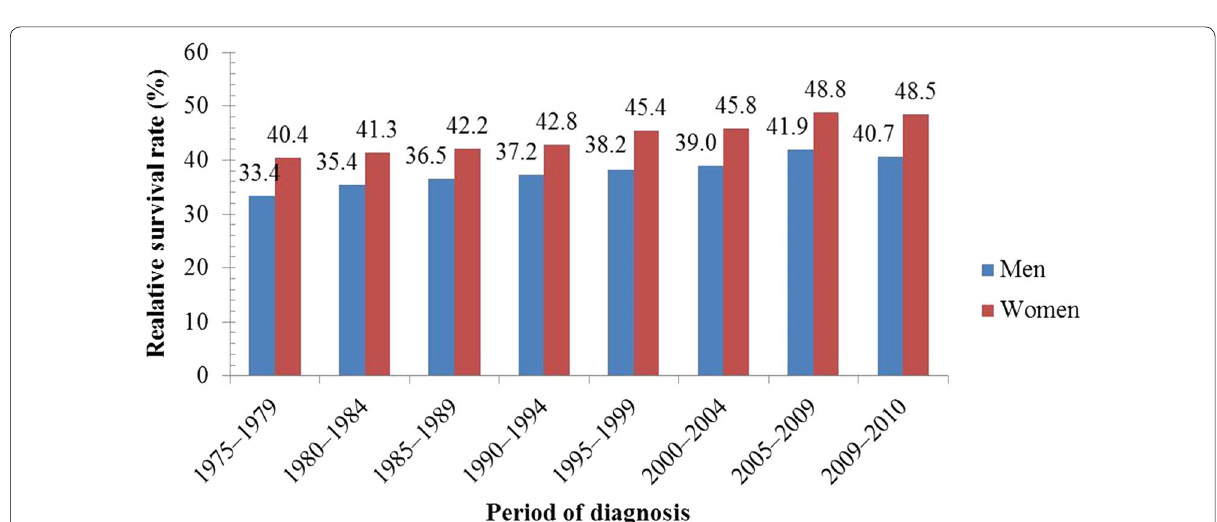
Fig. 5 One-year relative survival trends of lung cancer patients in the United States (US). During the period 1975–2010, 1-year relative survival rate for men with lung cancer increased from 33.4% to 40.7%; for women, it increased from 40.4% to